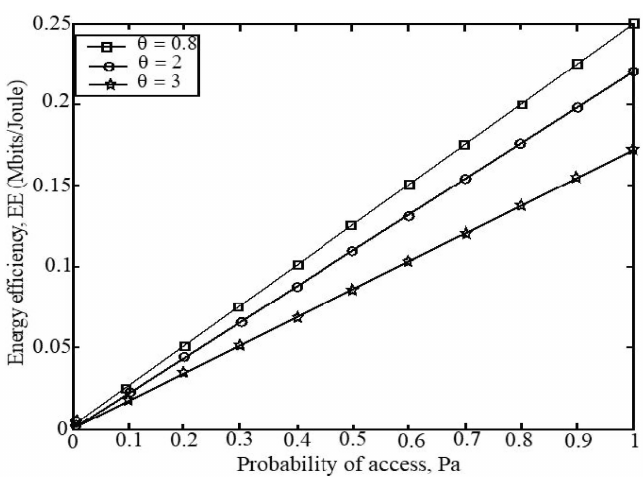
Figure 9. Representation of the EE when the detection power is considered in the CCRNs as a function of the probability of access to different detection factors θ .